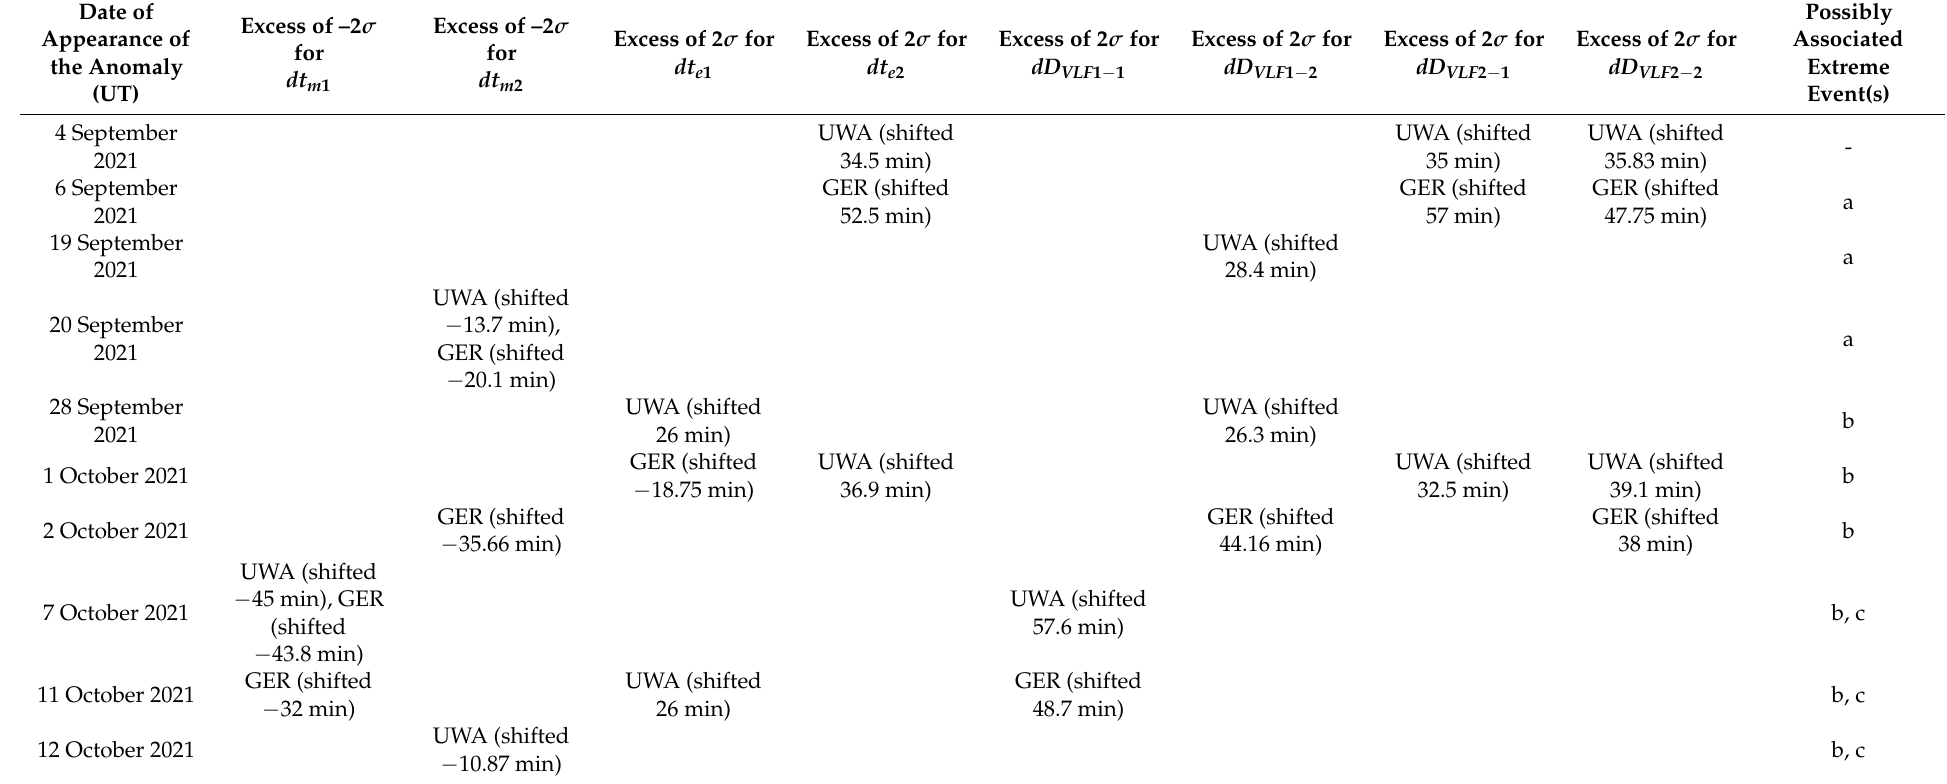
Table 7. Results of TTM analysis for the 2021 Crete EQs. UWA and GER denote the station where the corresponding anomaly has been